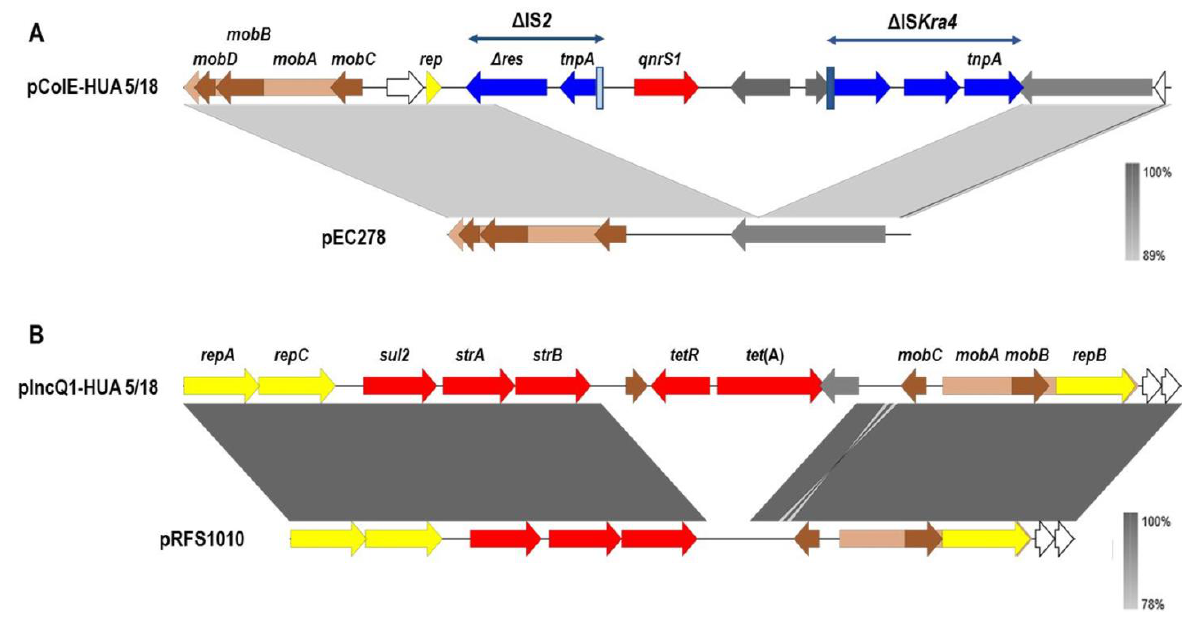
Figure 1. Genetic organization of the ColE ( A ) and IncQ1 ( B ) plasmids carried by Salmonella enterica serovar Corvallis isolates from a Spanish hospital. The alignments of the ColE and IncQ1 plasmids with pEC278 (accession number AY589571) and pRFS1010 (accession number M28829), respectively, were created with EasyFig BLASTn. The gray shading between regions reflects nucleotide sequence identities according to the scales shown at the right lower corner of the figures. The open reading frames (ORFs) are represented by arrows pointing to the direction of transcription and having different colors according to their function: red, resistance; yellow, plasmid replication; brown, mobilization; blue, insertion sequences; grey, other roles; white, hypothetical proteins. Vertical boxes indicate truncated (pale blue) and intact (dark blue) inverted repeats of IS 2 -like and ISKar4-like elements, respectively. The mobA gene in the ColE plasmids (pale brown) partially ( mobC ) or totally ( mobB and mobD ) overlaps the other mob genes. The mobA gene of the IncQ plasmids (pale brown) overlaps with mobB and repB .